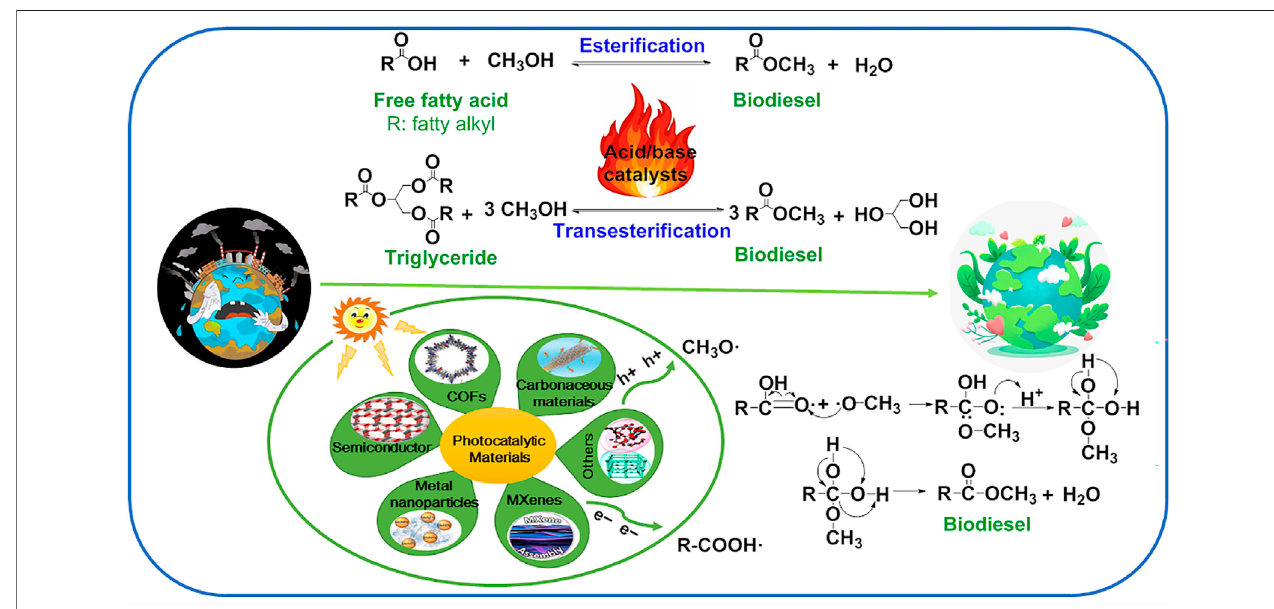
FIGURE1| Schematicillustrationofthermal-andphoto-drivenbiodieselproductionfromFFAusingacid/basecatalystsandphotocatalyticmaterials.Adaptedwith permissions from Corro et al., 2017; de Medeiros et al., 2020; Ghani et al., 2021; Guo et al.,